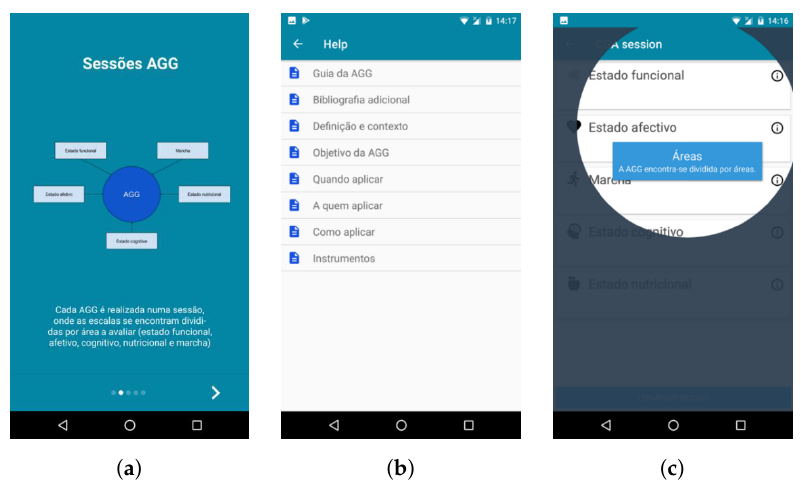
Figure 4. Screens for the ( a ) tutorial home screen, providing a short explanation about CGA, ( b ) help menu, 0 and ( c ) guided tour features added to the fourth prototype of Geriatric Helper.